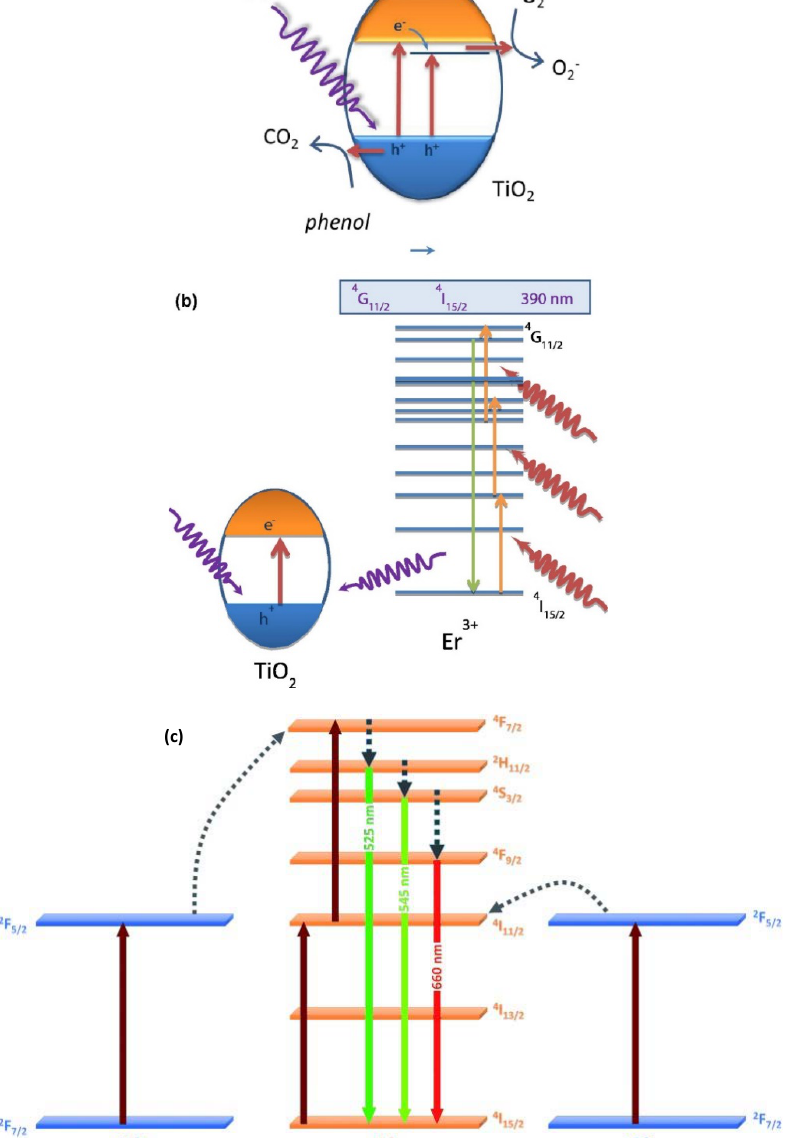
Figure 2. Proposed electronic mechanism for Er 3+ doping of TiO 2 occurring under UV excitation ( a ) and near-infrared (NIR) excitation ( b ). Reprinted with permission from [38]: Obregón, S. et al. J. Catal.